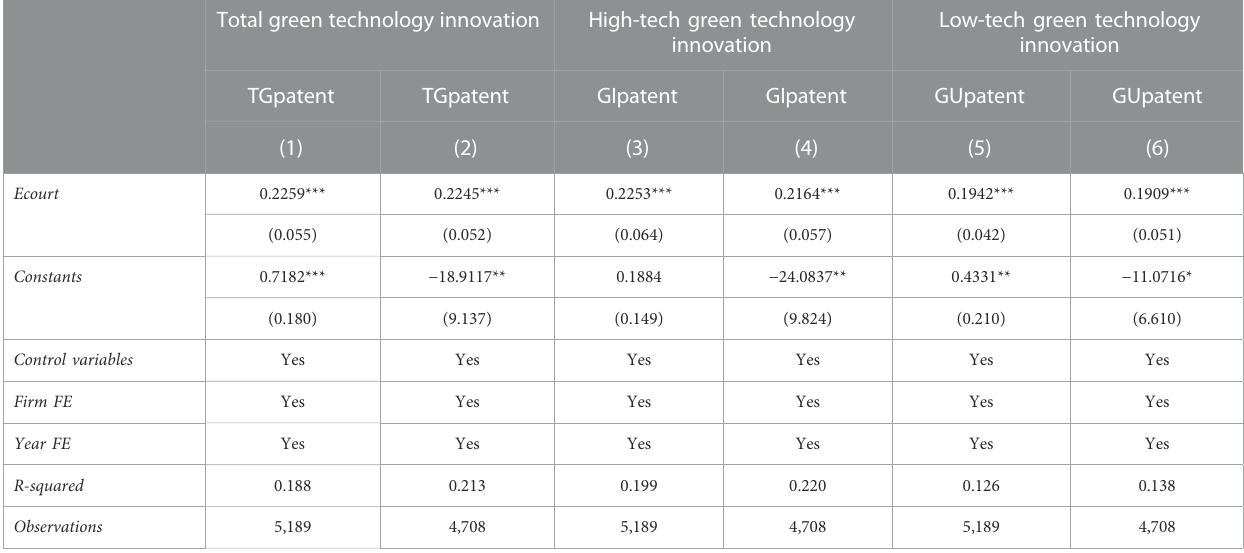
TABLE 5 Results with Tobit and ZINB